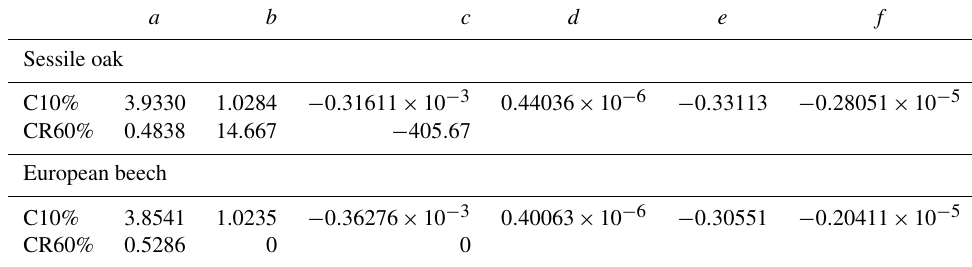
Table C1. Parameters of Eqs. (C3) and (C4) for sessile oak and European beech according to Dagnelie et al. (1999). a b